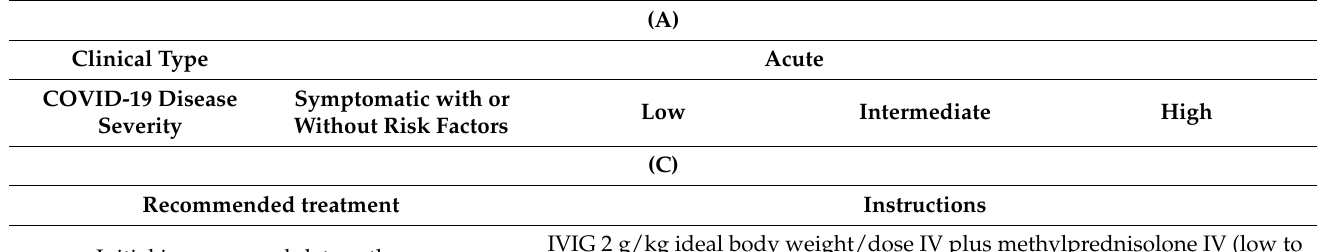
Clinical Type COVID-19